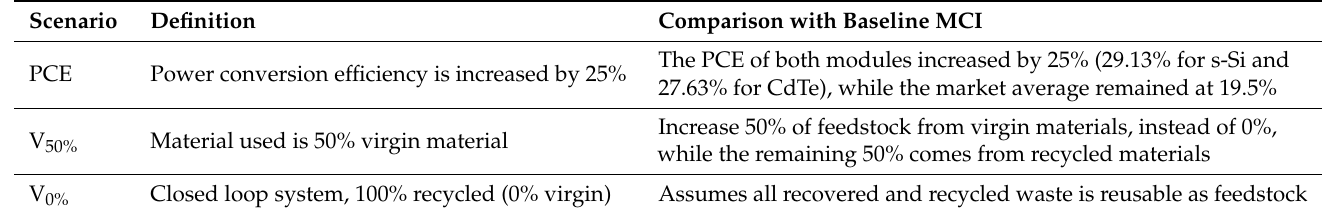
Table 2. Additional scenarios for calculating the material circularity index; PCE is a scenario of power-conversion efficiency increase, and V 50 and V 0% are feedstock scenarios. These scenarios are also considered for their combinations, including (1) V 50% + PCE and (3) V 0% + PCE. Scenario Definition Comparison with Baseline MCI The PCE of both modules increased by 25% (29.13% for s-Si and 27.63% for CdTe), while the market average remained at